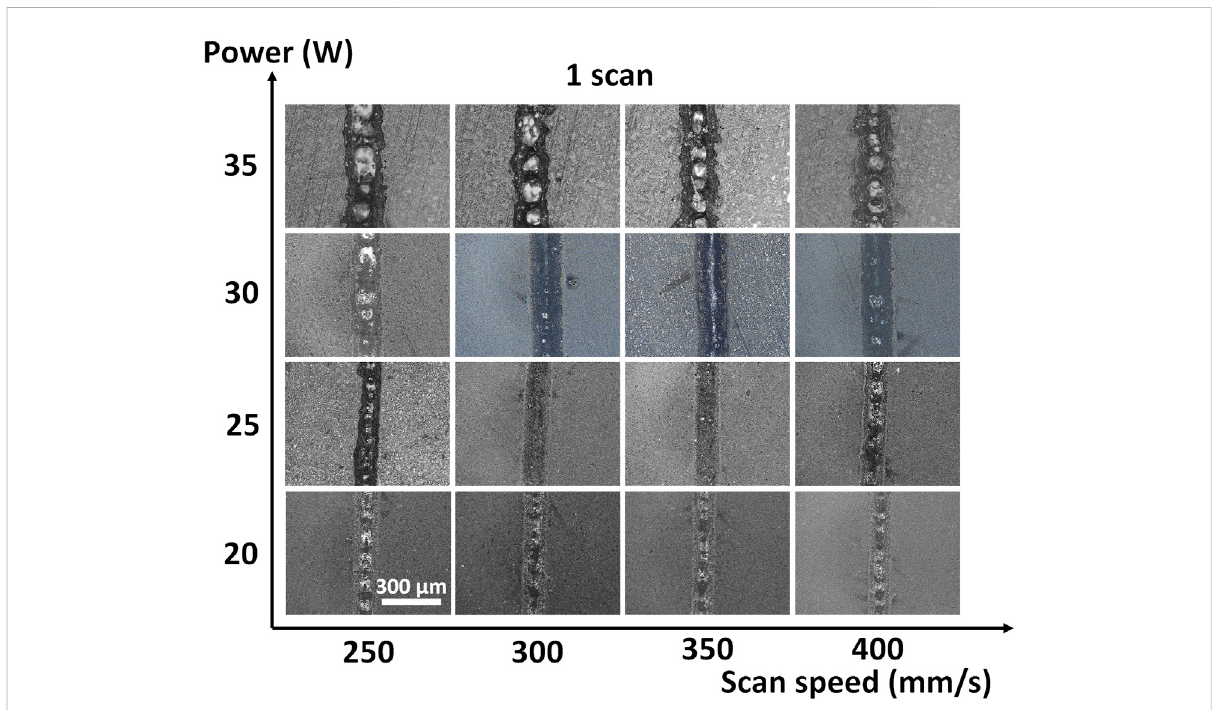
FIGURE 4 Optical microscope images of the top surfaces of the single laser scan melt tracks on Bi 2 Te 3 powder compacts for a range of incident laser power and scan